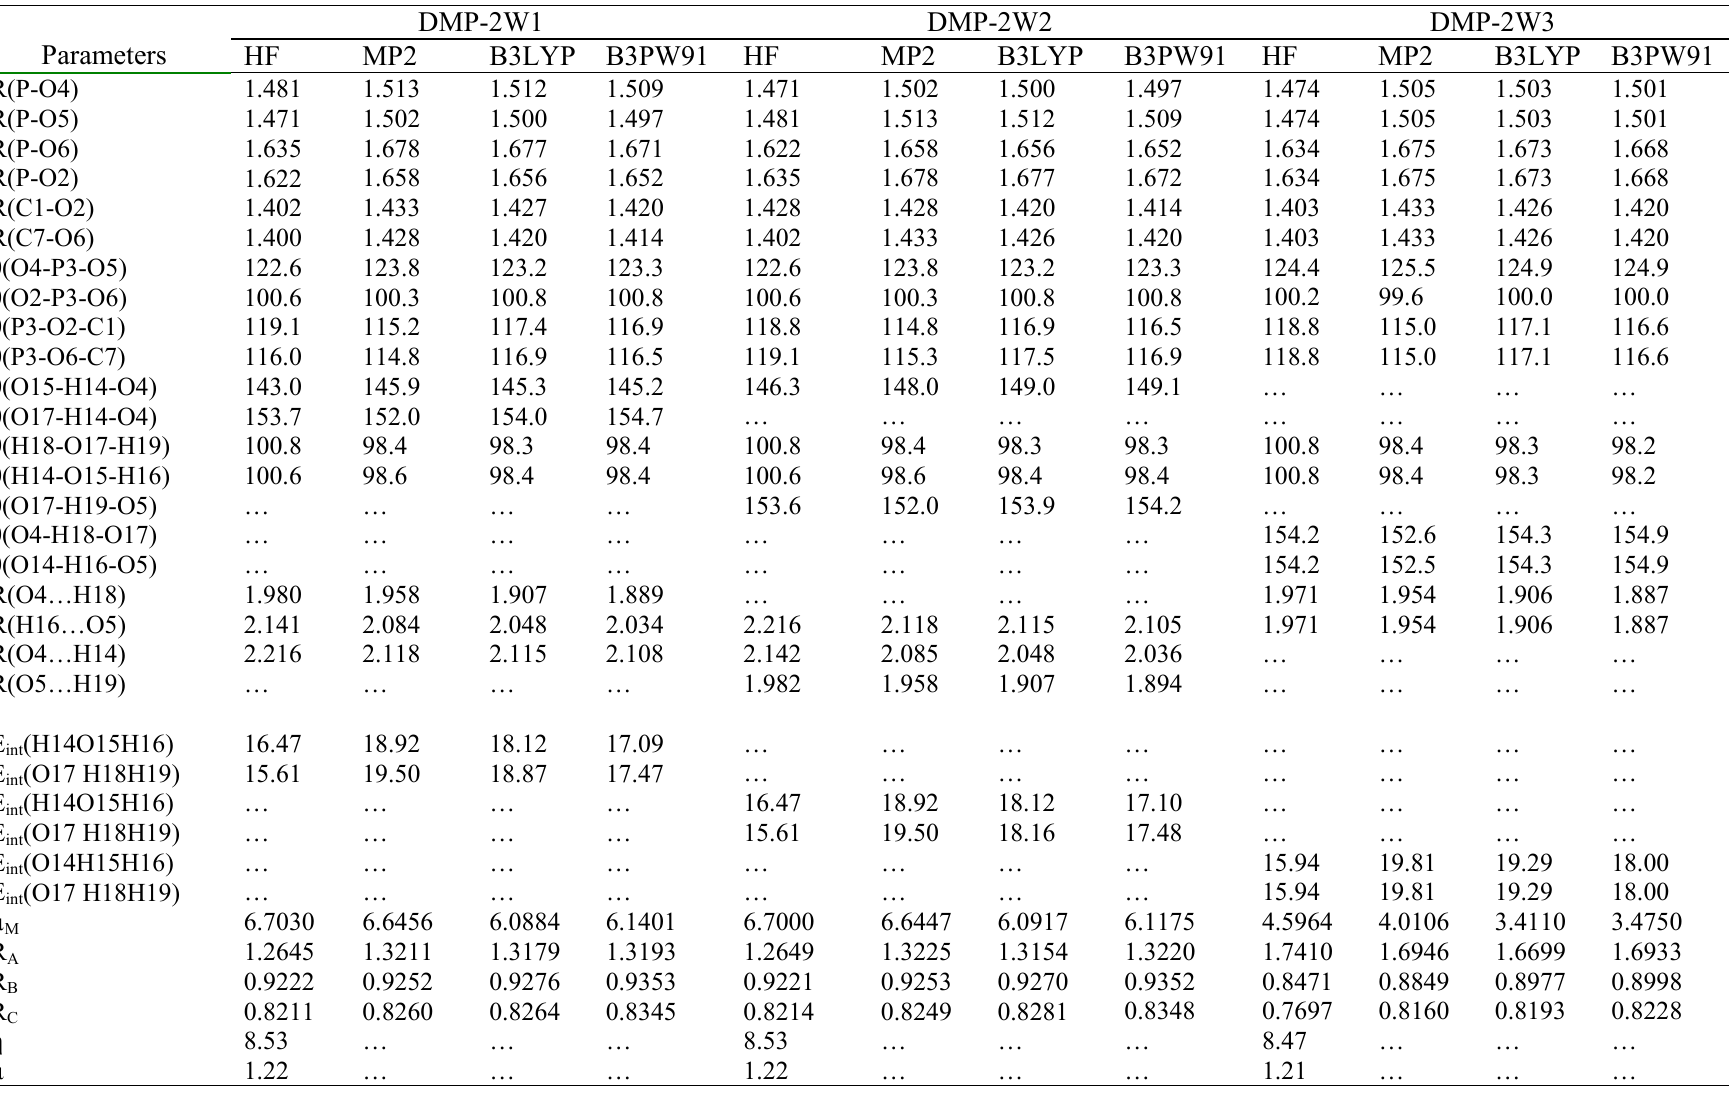
Table 3. Optimized geometrical parameters (bond length in Å, bond angle in degrees), rotational constants R Debye), chemical potential µ (in eV) and chemical hardness η (in eV) for DMP-2 water